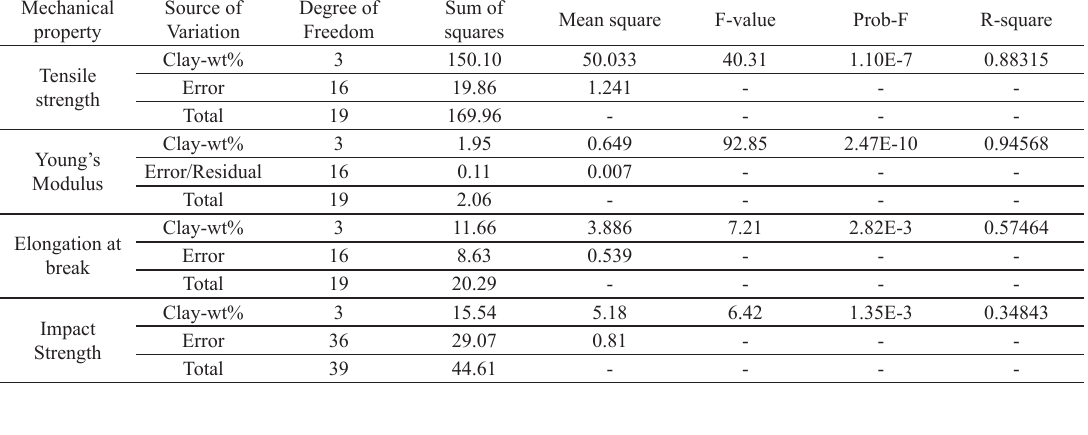
Table 2. Main ANOVA results for the mechanical properties studied.